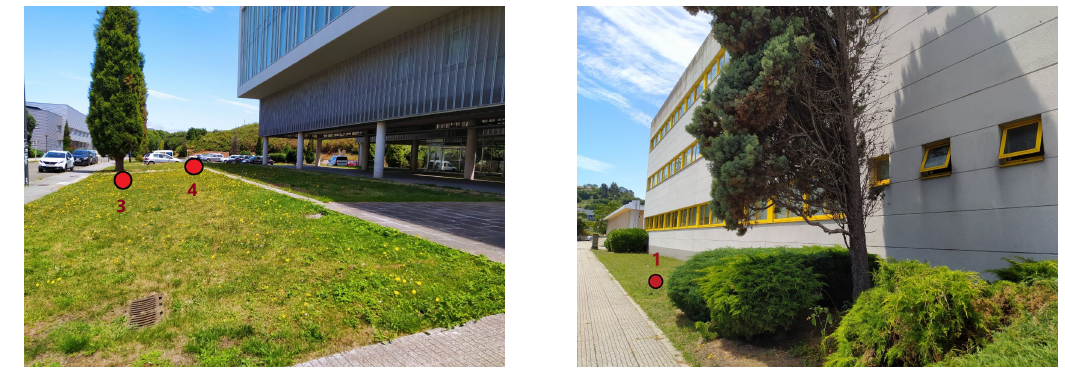
Figure 2. Areas where smart irrigation nodes 3 and 4 ( left ) and 1 ( right ) were